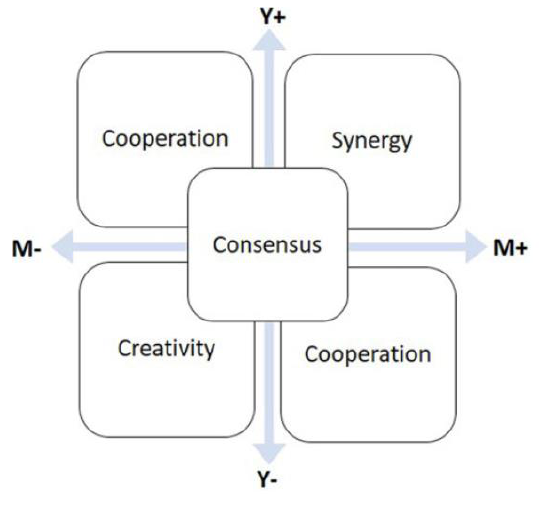
Figure 21: Conflict Strategies: Outcome for I’m OK, You’re OK Life Position (Suriyaprakash & George, 2015, p.274)